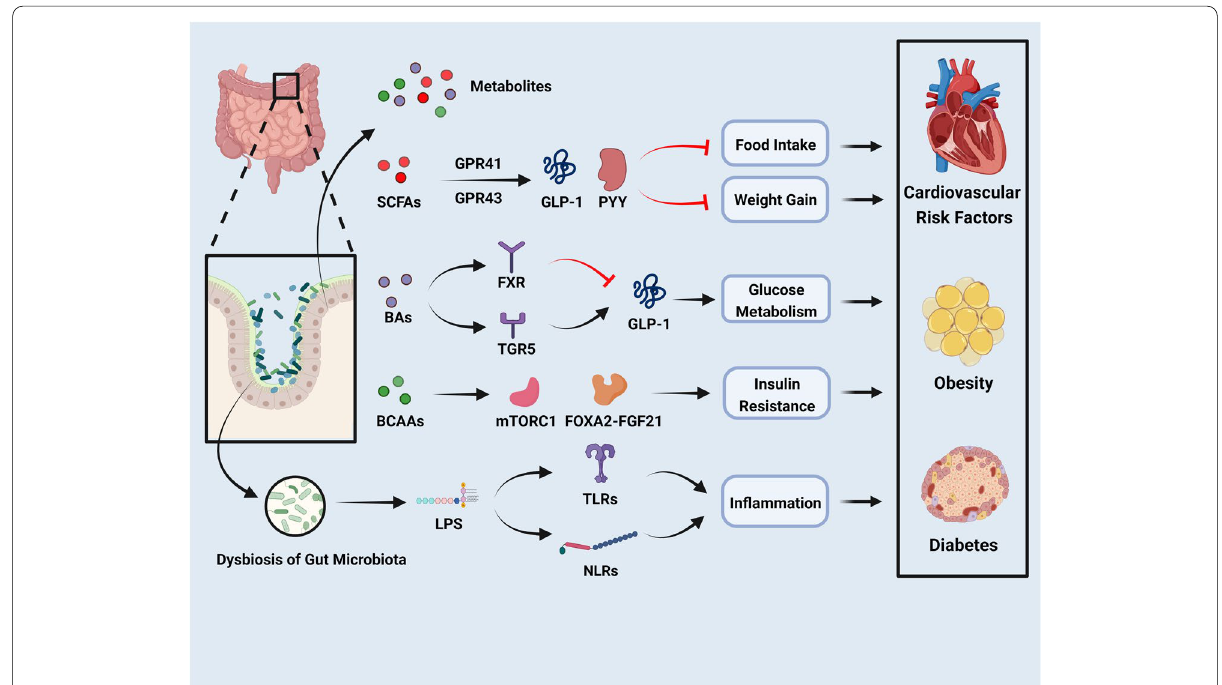
Fig. 3 The gut microbiota dysbiosis and its metabolites promote the development of cardiovascular risk factors (created with BioRender.com). The dysbiosis and metabolites of gut microbiota promote the development of obesity and diabetes by increasing myocardial lipotoxicity, diabetic cardiomyopathy, and cardiac insufficiency. SCFAs interact with GPR41/GPR43 to release GLP-1 and PYY, and thus to reduce food intake and weight gain. BAs combine with FXR and TGR5 to regulate glucose metabolism by influencing the release of GLP-1, but their role in obesity and diabetes is controversial. BCAAs regulate mTORC1 and FOXA2-FGF21 to promote insulin resistance. Furthermore, LPS regulates TLRs and NLRs to induce inflammation. Abbreviations: SCFAs: short-chain fatty acids; BCAAs: branched-chain amino acids; BAs: bile acids; LPS: lipopolysaccharide; TGPR, G-protein-coupled receptors; GLP-1: glucagon-like peptide 1; PYY: peptide YY; mTORC1: mammalian target of rapamycin complex 1; FOXA2: forkhead box protein A2; FGF: fibroblast growth factor; FXR: farnesoid X receptor; TGR5: takeda-G-protein receptor 5; TLRs: Toll like receptors; NLRs: Nod-like